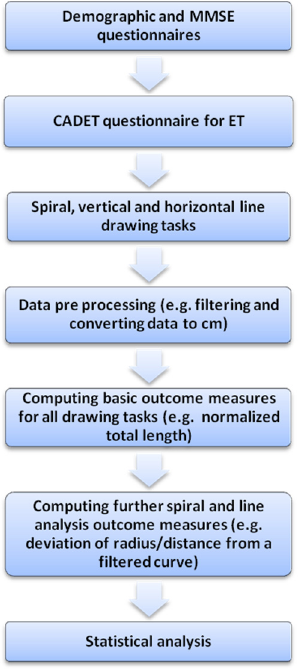
Figure 1. A flowchart describing research methods.